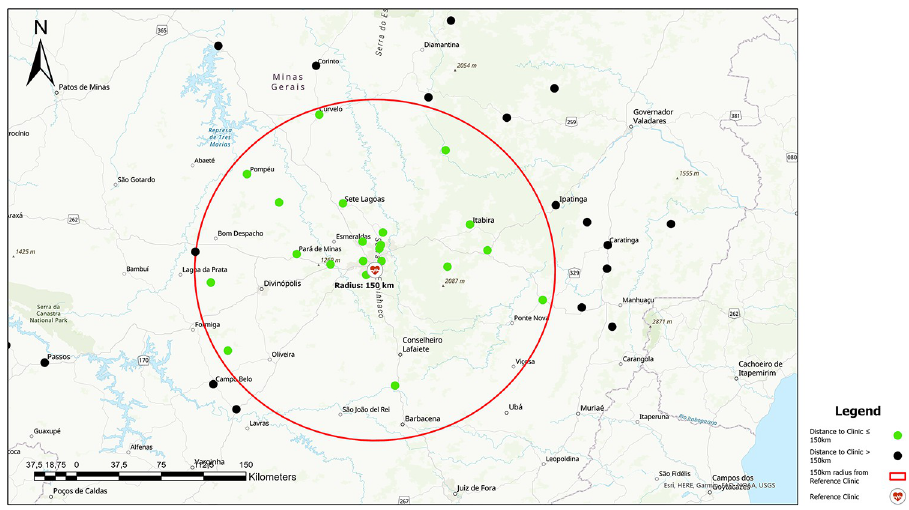
Fig 1. Map of the Brazilian state of Minas Gerais and capital city, Belo Horizonte, patient residences mapped, circle delineating 150km from reference clinic, green markers within radius (ESRI ArcMap).